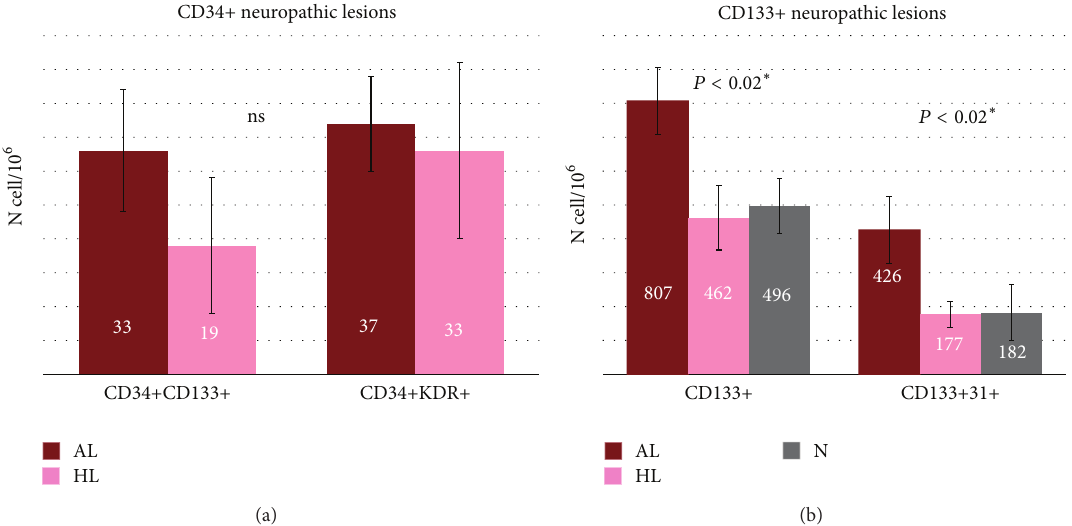
Figure 3: Levels of CD34+ (a) and CD133+ (b) progenitor cells in neuropathic lesions in type 2 diabetic subjects depending of healing or not healing time course. AL acute lesions (brown), HL healed lesions (pink). 𝑃 < 0.02 in CD133+ AL in N1 patients versus HL in N1 and N